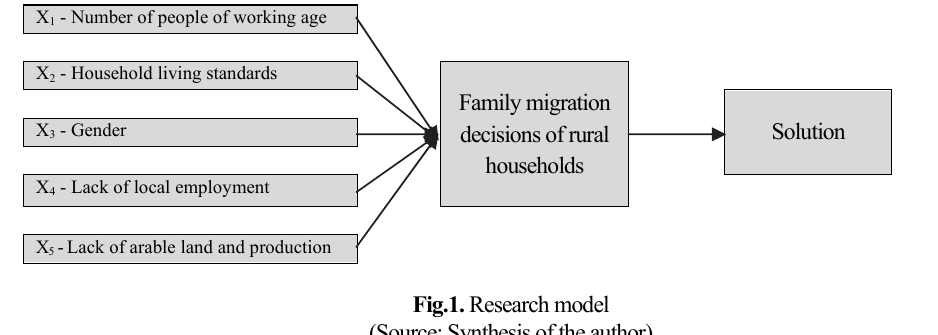
Fig.1. Research model